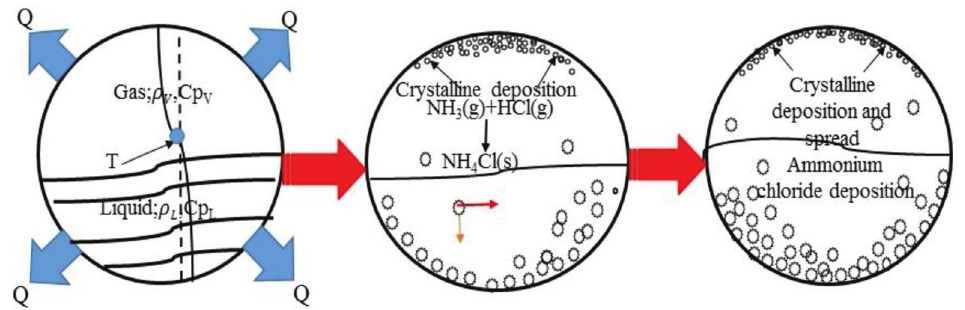
Figure 7. Crystallization and deposition corrosion mechanism of ammonium